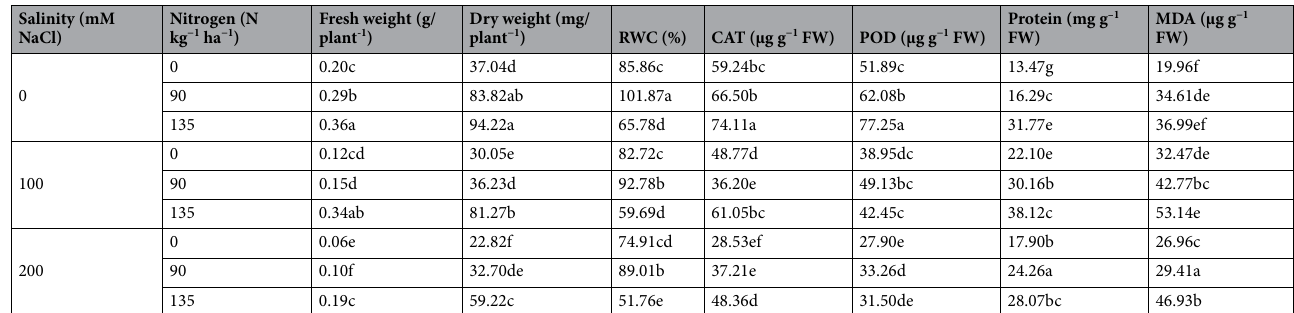
Table 4. Impacts of salinity and nitrogen on fresh weight, dry weight, relative water content (RWC), CAT, POD, protein content and MDA content on seedling of sorghum. Within the same column, means followed by the different letters are statistically different at P ≤